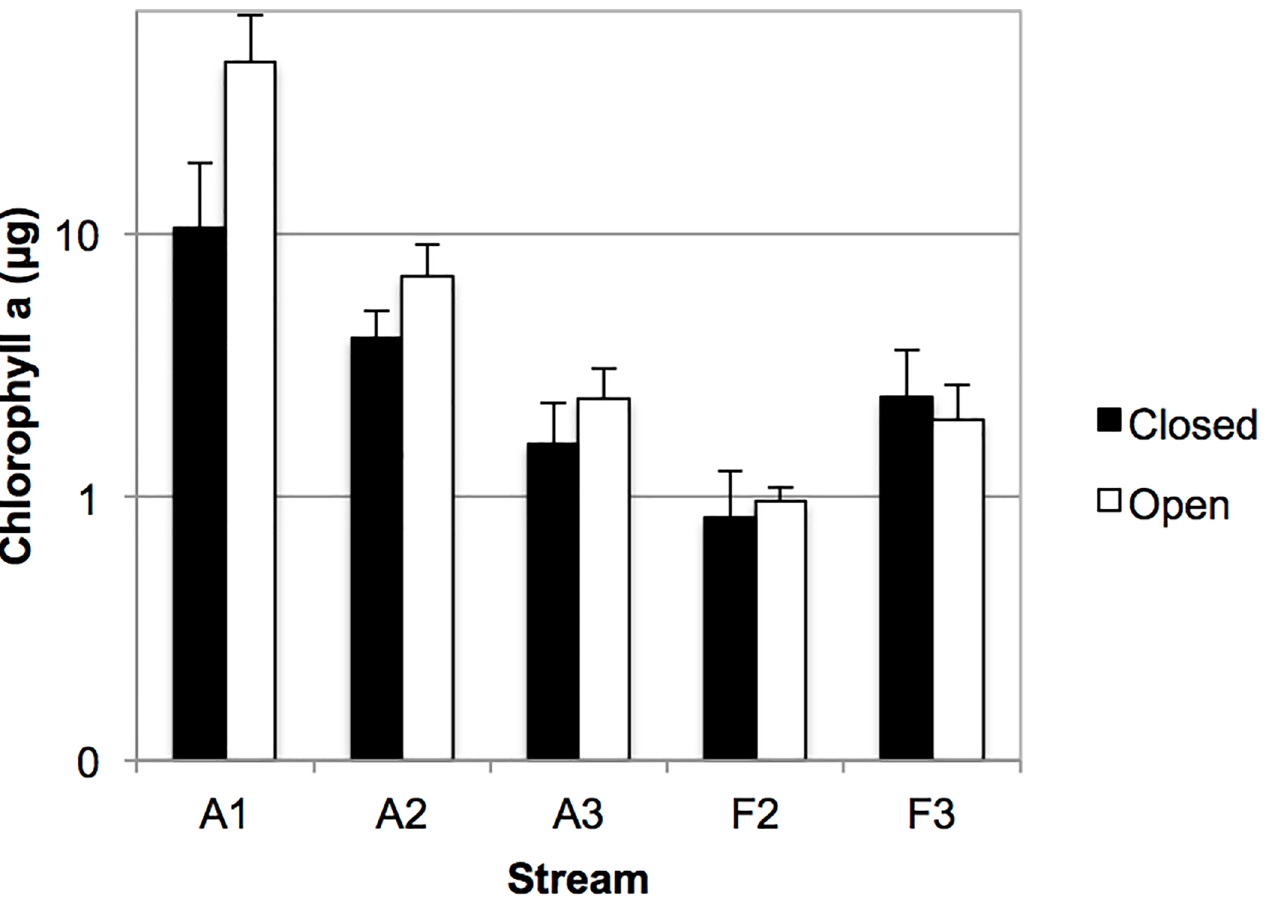
Fig 1. Chlorophyll a per pair of biofilm carriers. Black columns, closed reaches, white columns, open reaches of agricultural (A) and forest (F) streams. Values are arithmetic means, error bars show standard deviation. Note logarithmic scale.